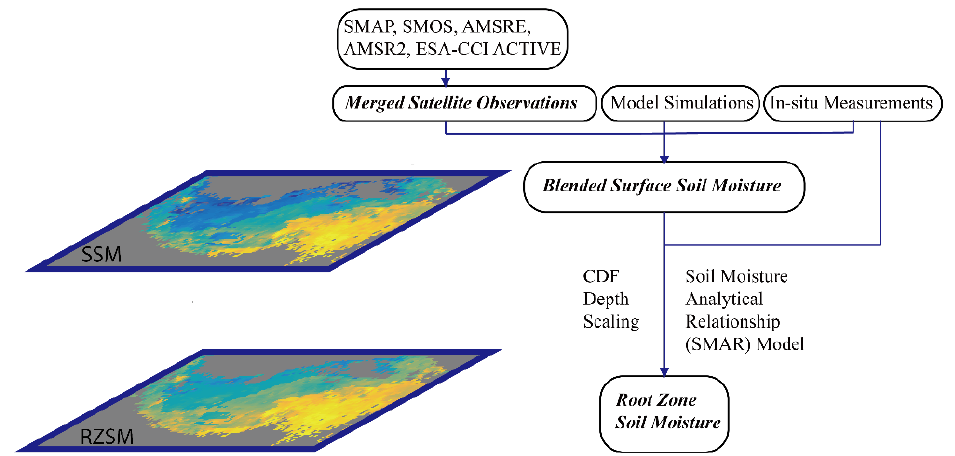
Figure 4. The example workflow for deriving root zone soil moisture (RZSM) from surface soil moisture (SSM), which results in ~10-year consistent surface and root zone soil moisture over Tibetan Plateau (adopted from [71] ).